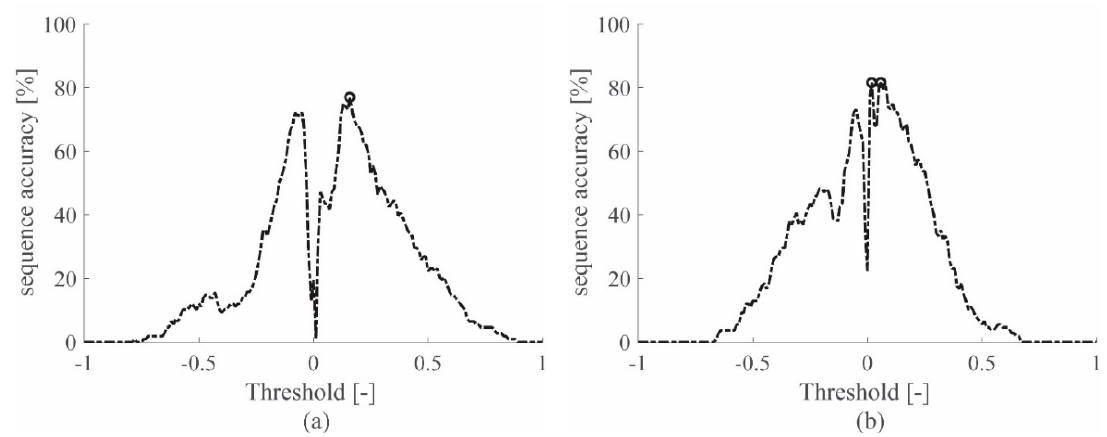
Figure 5. Sequence accuracy of the ACC signals on the aluminum plate ( a ) and the sandwich panel ( b ), when the 0–619 Hz or 0–1689 Hz filter is applied, respectively.